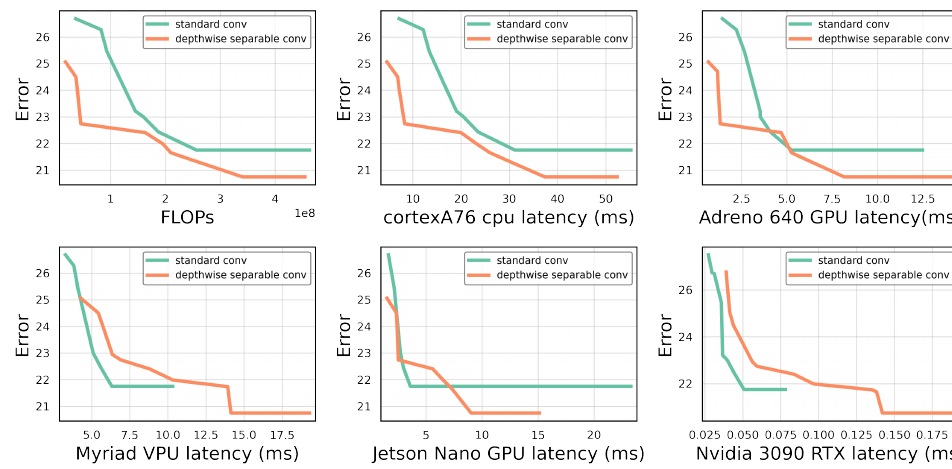
Figure 5. Depthwise separable convolutions are efficient when evaluated by FLOPS (upper left), but this does not translate to faster inference on all embedded hardware